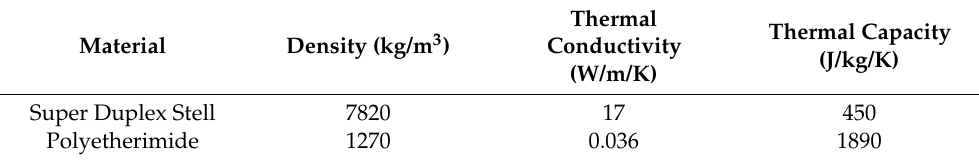
Table 3. Physical and thermal proprieties of super duplex steel and polyetherimide used in the transient heat transfer model in COMSOL.